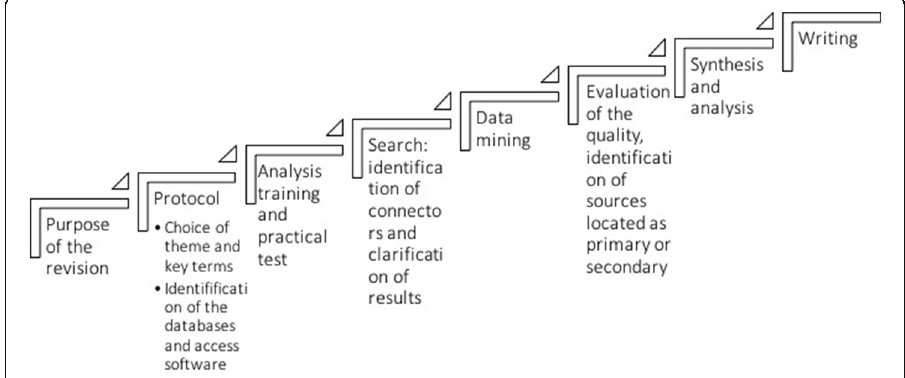
Fig. 2 Procedure of literature review. Source: Adaptation of McMillan & Schumacher, 2010 and Okoli & Schabram, 2010. Own